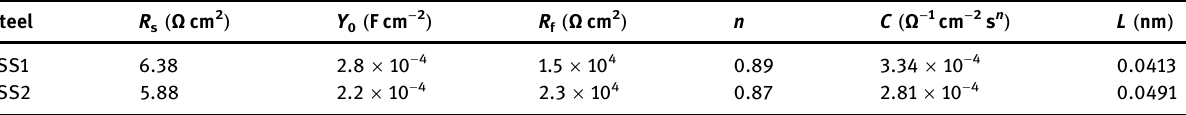
Table 2: Fitting parameters of EIS data from an equivalent circuit Steel